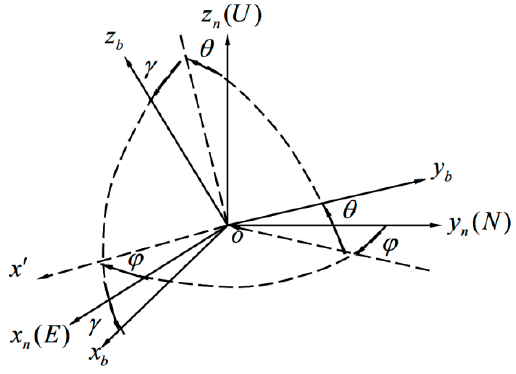
Figure A1. Carrier and navigation coordinate systems.